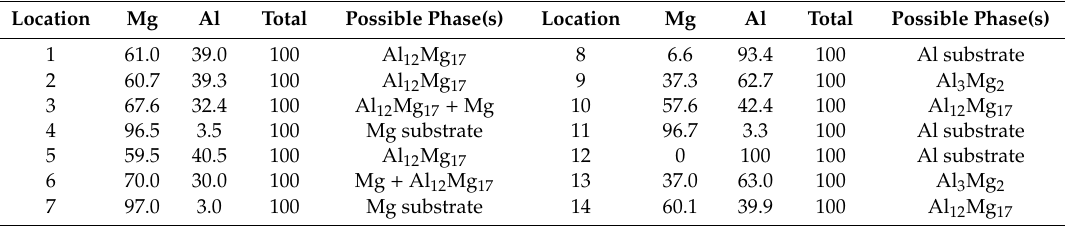
Figure 5. SEM micrographs and EDS maps of the AZ31B Mg alloy interface: ( a – d ) represent the location A, B, C and D, respectively. Table 2. Chemical compositions (Weight Percent) measured by EDS at Locations shown in Figure 5.